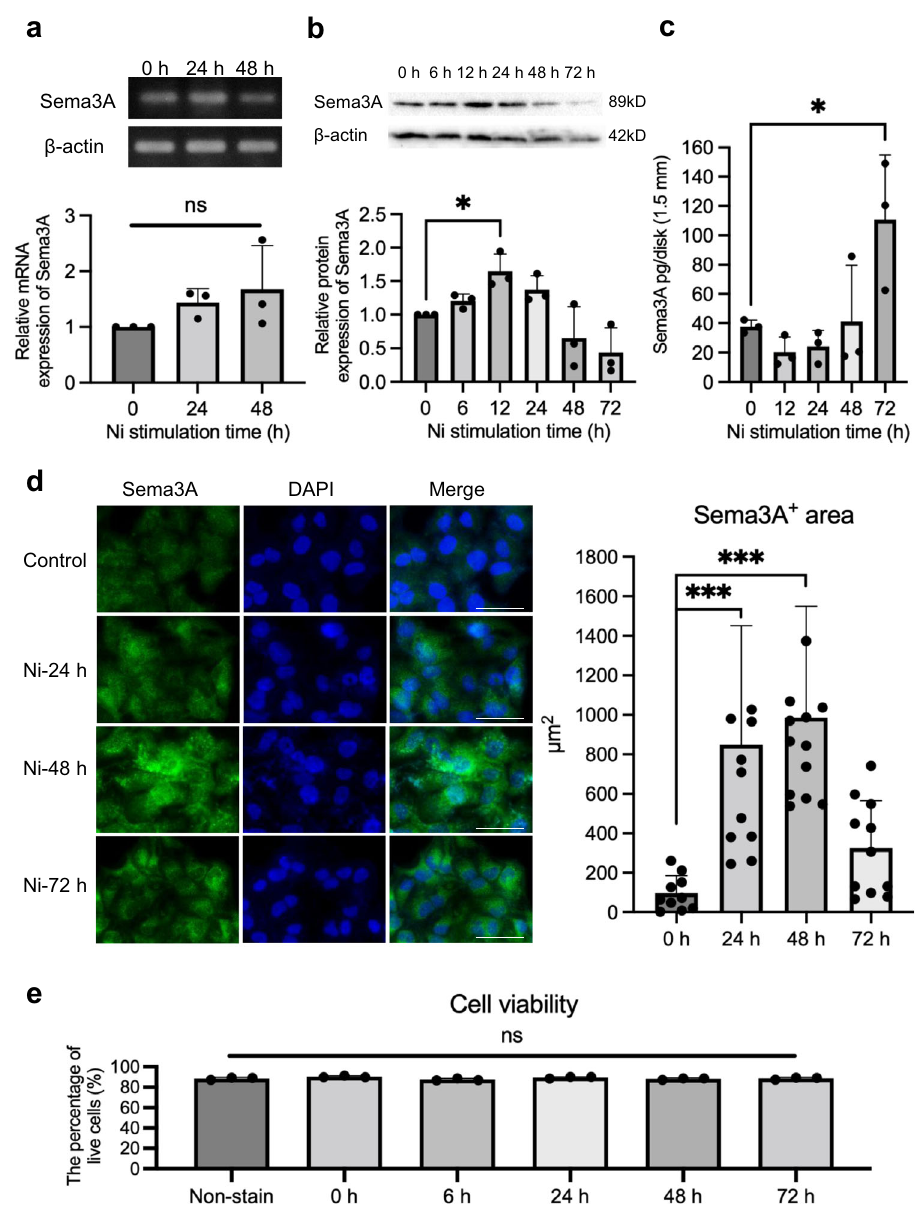
Fig. 1 Ni stimulation upregulates Sema3A expression in Pam2.12 cells. a Sema3A was expressed on NiCl 2 -stimulated Pam2.12 cells and its mRNA levels increased after NiCl 2 stimulation. Gene expression was normalized to levels of β -actin. N = 3. b Upregulated Sema3A in NiCl 2 -stimulated Pam2.12 cells analyzed by western blotting. β -actin was used as the internal control. N = 3. The uncropped Western blotting image is shown in Supplementary Fig. 5a. c Upregulated Sema3A production in NiCl 2 -stimulated Pam2.12 cells analyzed by ELISA. N = 3. d Immunocytochemistry of Sema3A expressed in Pam2.12 cells 24, 48, and 72 h after NiCl 2 stimulation. Scale bar, 50 µ m. Quanti fi cation of the area of Sema3A-positive Pam2.12 cells (at least 10 images/group) after Ni stimulation analyzed by BZ-X800 Analyzer software. e The population of live Pam2.12 cells after stimulation with 250 µ M Ni for different durations analyzed by fl ow cytometry using propidium iodide staining. N = 3. Data are shown as mean ± SD and are representative of at least three independent experiments. Different letters on bars indicate signi fi cant differences. * p < 0.05, *** p < 0.001; One-Way ANOVA with LSD. Supplementary Data and p values are provided as a Supplementary Data fi